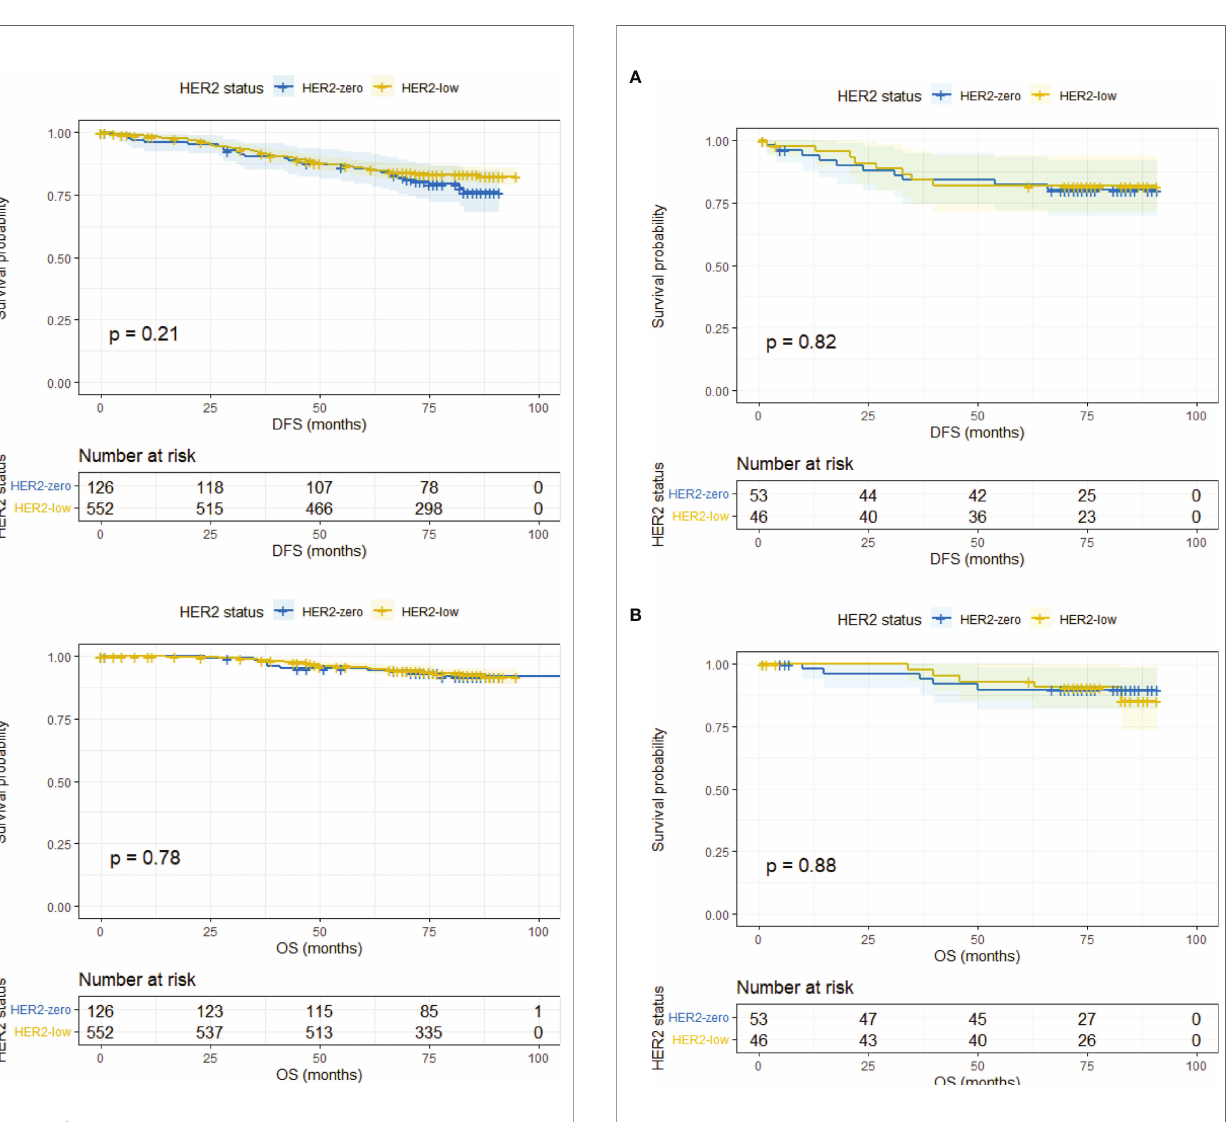
FIGURE 3 | DFS and OS in HR-negative/HER2-zero and HR-negative/HER2- low patients. (A) DFS in HR-negative/HER2-zero and HR-negative/HER2-low patients. (B) OS in HR-negative/HER2-zero and HR-negative/HER2-low